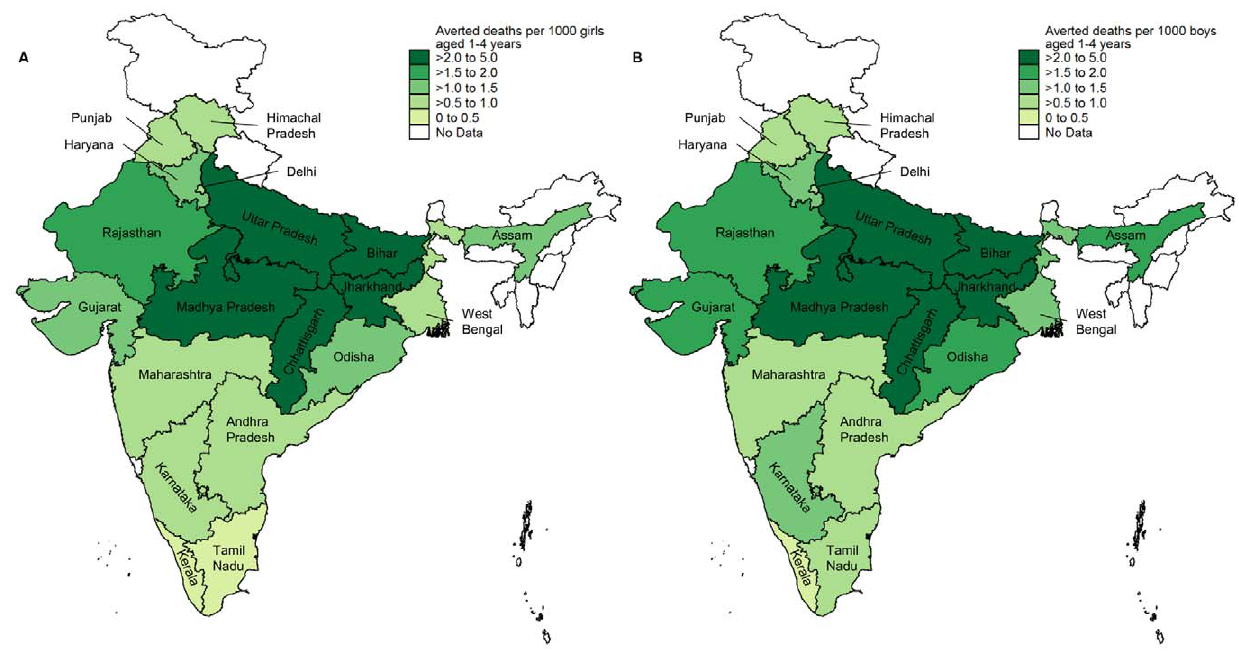
Figure 4. Averted deaths in 2009 by sex attributable to increased social sector spending since 1997. Averted deaths per 1,000 population among A) girls and B) boys aged 1–4 years. The population denominator is the sex-specific population aged 1–4 years in 2009. In the analysis, data from Jharkhand was combined with that from Bihar and data from Chhattisgarh with that from Madhya Pradesh. The averted death rates shown in the maps for these four states are therefore the averted death rates obtained for Bihar combined with Jharkhand and Madhya Pradesh combined with Chhattisgarh.